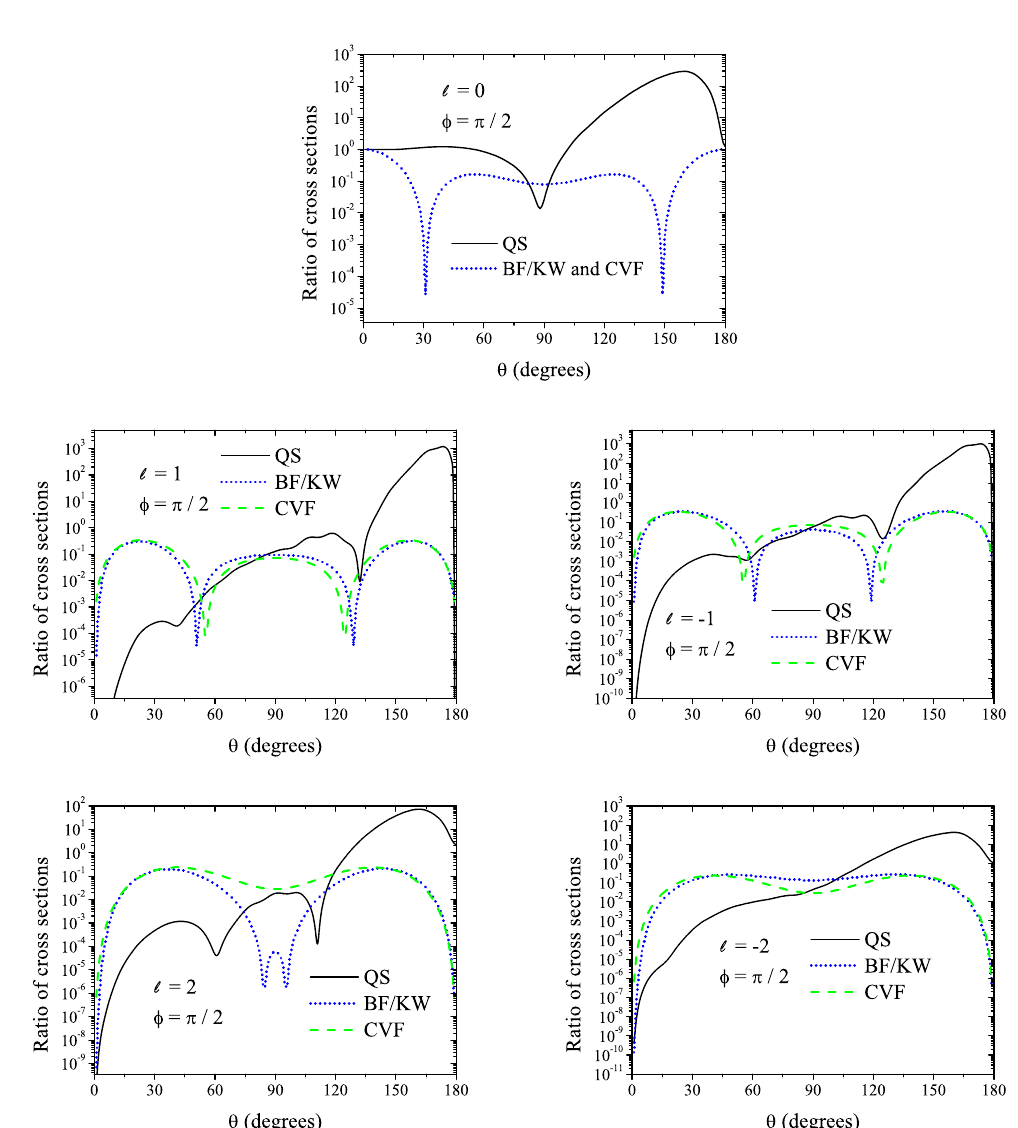
Figure 1. The ratio of differential cross sections (22) for photon numbers (cid:96) = 0, ± 1, ± 2 when the laser polarization vector is perpendicular to the incident electron momentum and lies in the scattering plane ( φ = π /2). The numerical results obtained using our quasi-Sturmian (QS) approach are compared with those using the Bunkin–Fedorov and Kroll–Watson approximations (BF/KW) and the Coulomb–Volkov function (CVF), Equations (23) and (24)